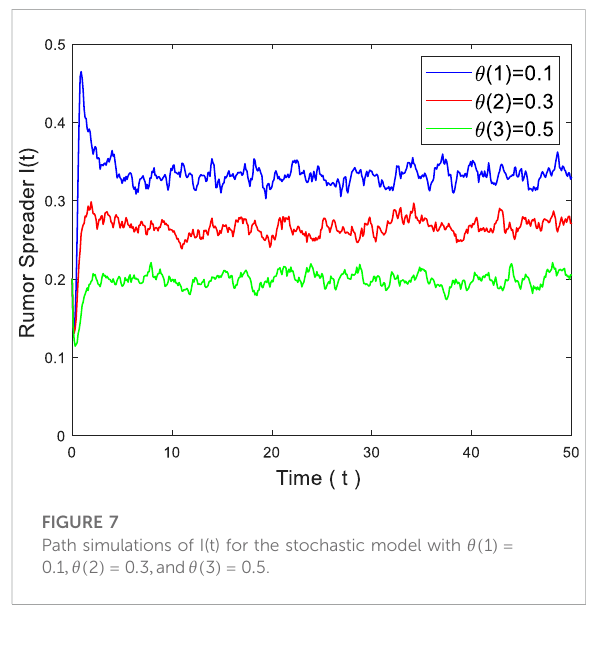
FIGURE 7 Path simulations of I(t) for the stochastic model with θ ( 1 ) (cid:2) 0 . 1 , θ ( 2 ) (cid:2) 0 . 3 , and θ ( 3 ) (cid:2) 0 .